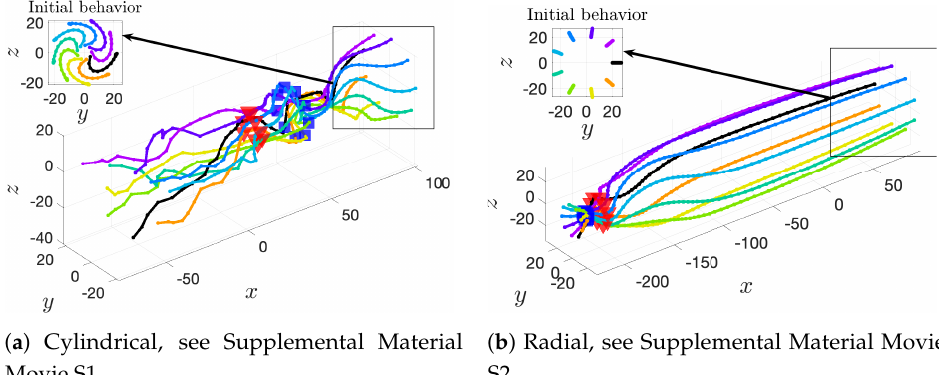
Figure 8. Paths of individual flagella over time, by plotting the head position once per beat over the simulation. Insets in panels ( a ) and ( b ) show how flagella move in the initial 1.4 s (14 beats) of the simulation. Blue squares denote the location of flagellum head where maximal efficiency is achieved and red triangles denote where minimal efficiency is achieved. Head positions start at x = 100 µ m and flagella move in the negative x -direction, so flagellum heads start at the far right and end in the far left of each image. All units are in µ m. Colors of curves correspond to the flagellum of the same color from the initial configurations in Figure